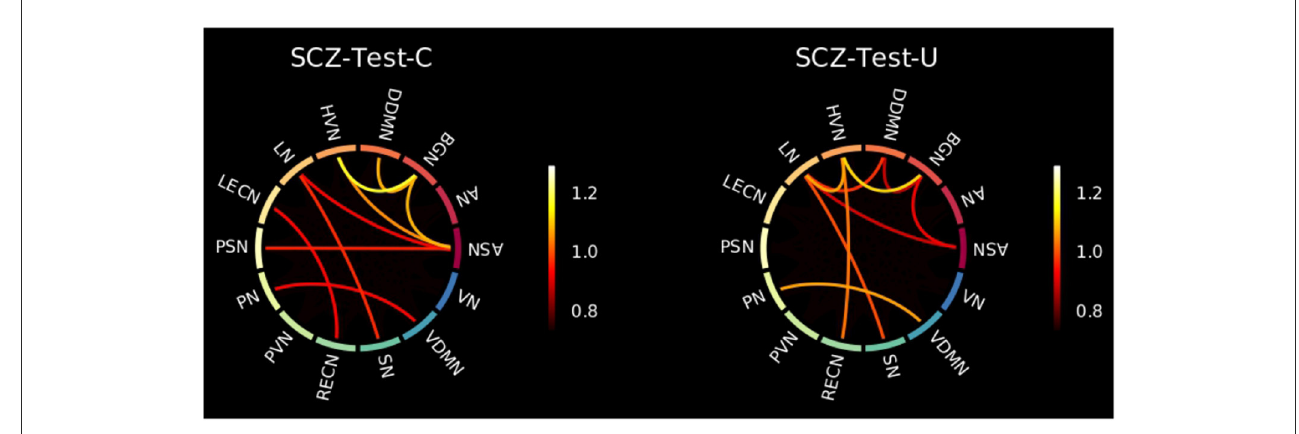
FIGURE10 Connectograms showing the 10 % of pairs of FBNs that were worse reconstructed for the SCZ patients of the COBRE (Left) and UCLA (Right) datasets. The color bar ranges between the lowest and highest values of those 10% of pairs of FBNs extracted from Figure 9.